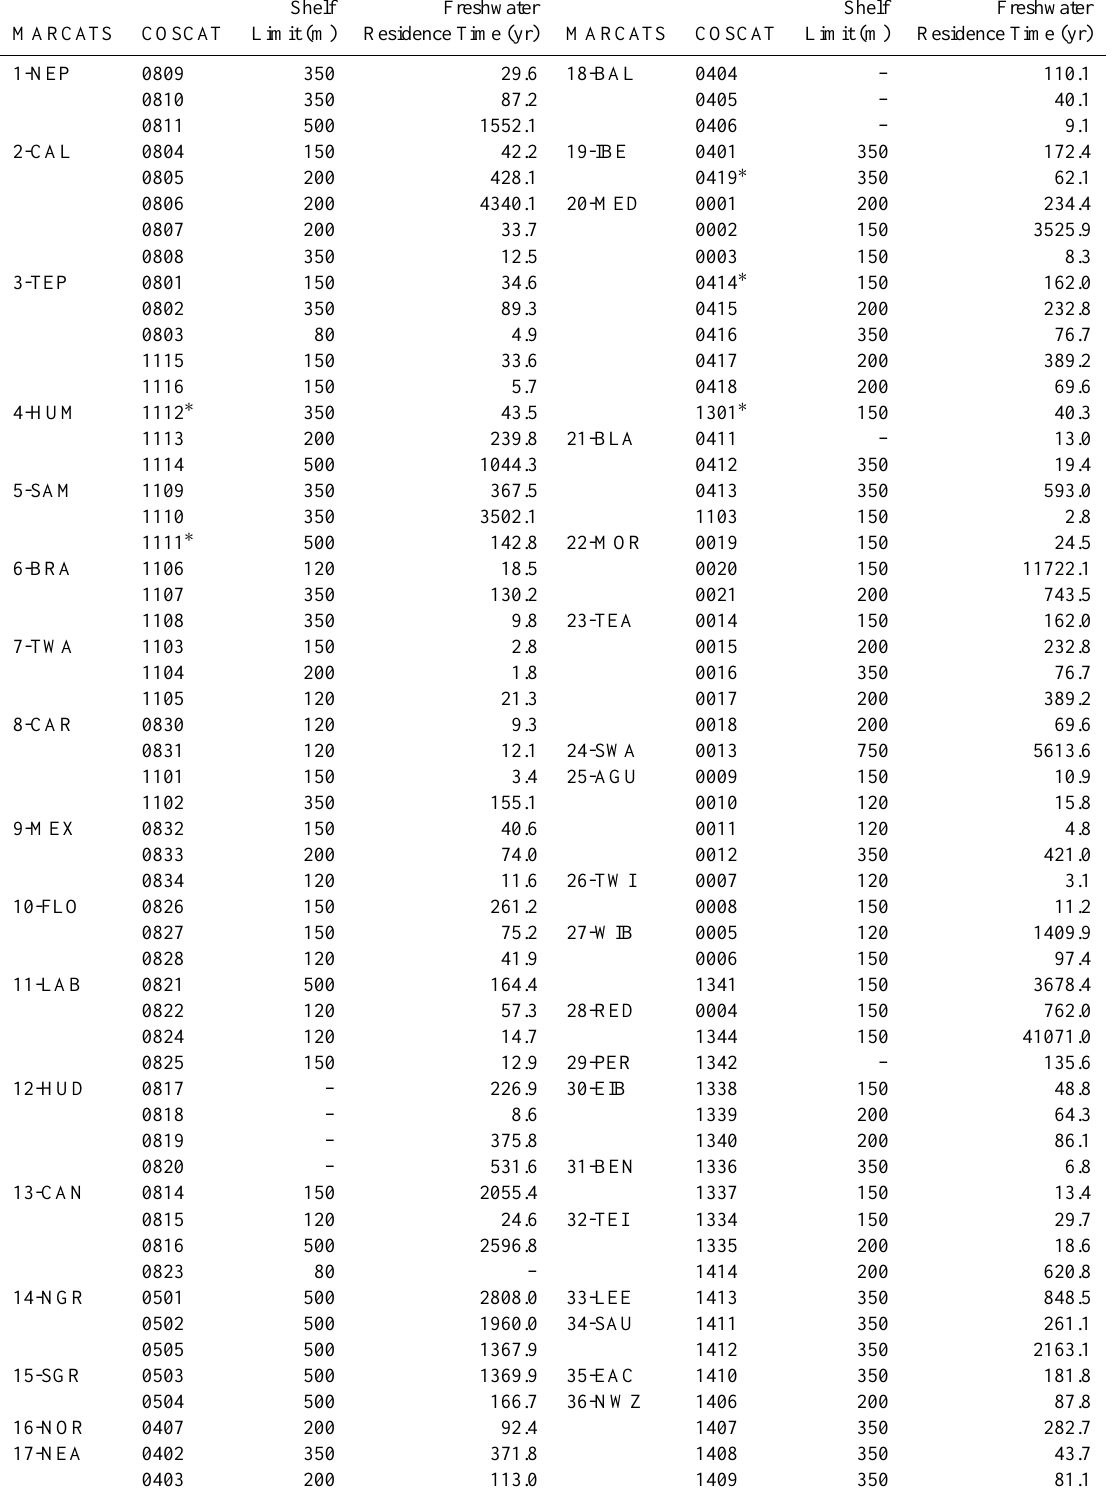
Table 2. List of the modified COSCAT segments with the depth of the outer limit of their continental shelves and the residence time of fresh water. COSCATs followed by a star ( ∗ ) have been defined or modified for the purpose of the present work. Shelf Shelf